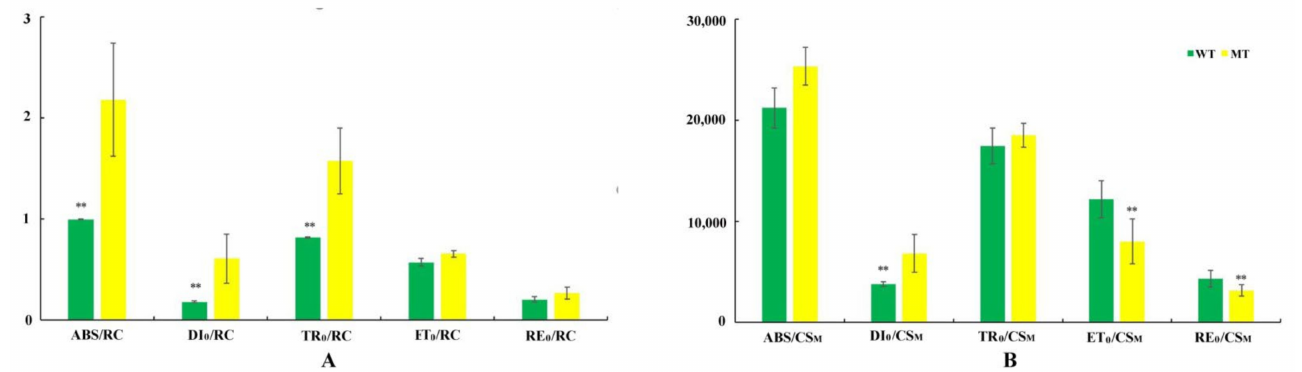
Figure 3. Energy flux models for the leaf samples of mutant-type and wild-type leaves under the same physiological conditions. The relative value of each parameter is proportional to the column height of the column charts. Graph ( A ) represents the specific activity on a single PSII reaction center (RC) basis. Graph ( B ) represents the specific activity on cross section (CS) basis. Bars represent the standard deviation of three repeats ( n = 3); ** indicates a significant difference at p <